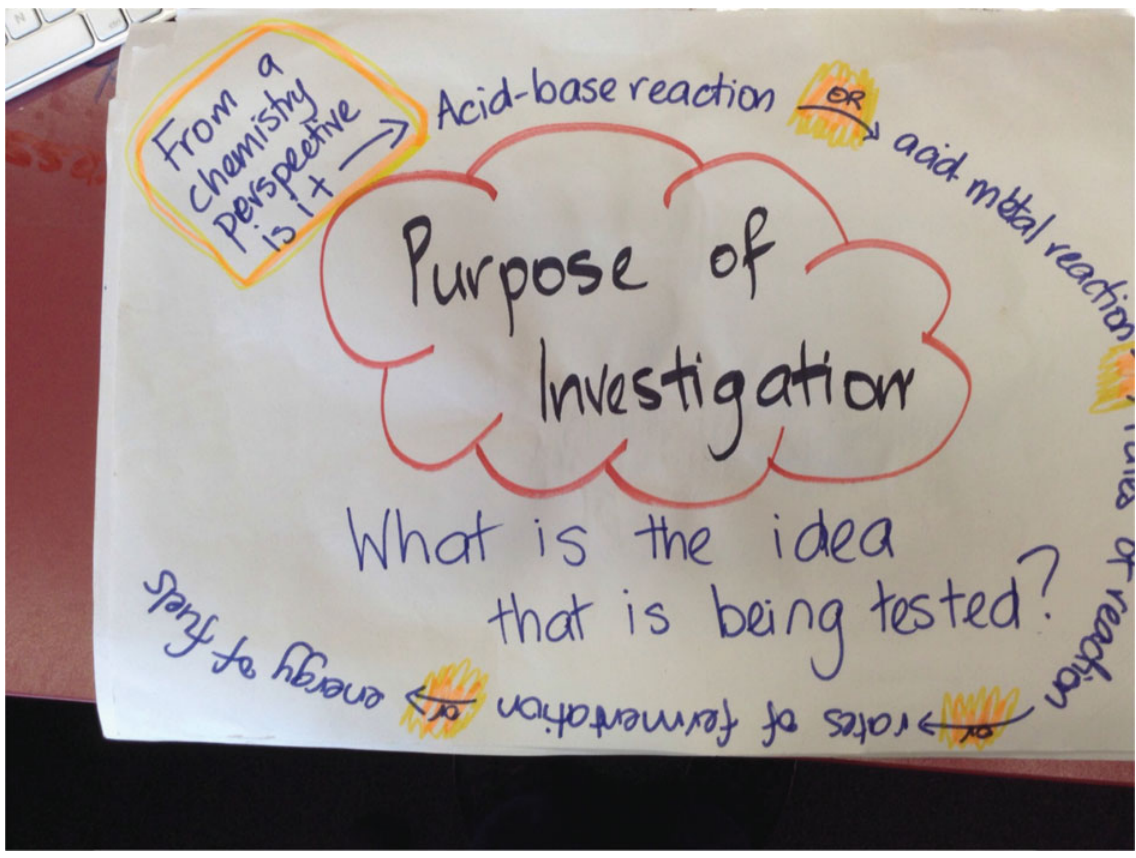
Collaborative mind map produced by the class showing the purpose of